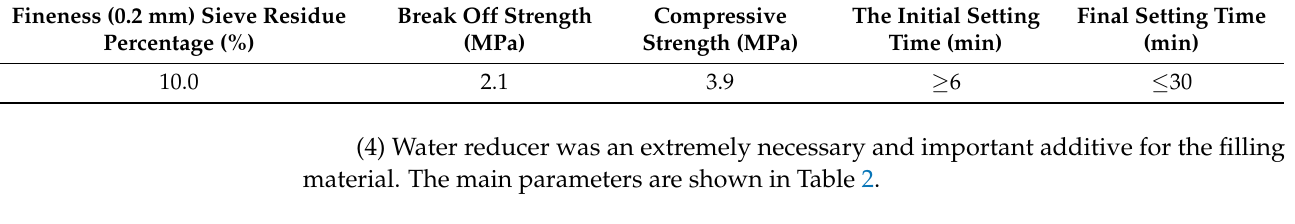
Table 2. Parameter table of water reducer.